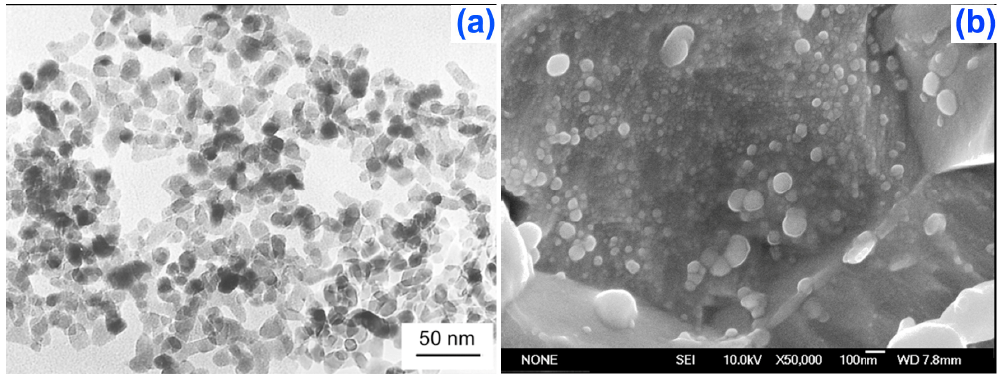
Figure 5. ( a ) TEM image of un-sintered ZrO plasma sintered ZrNiSn/2 vol% ZrO Reference [77]. Copyright 2004, Elsevier.